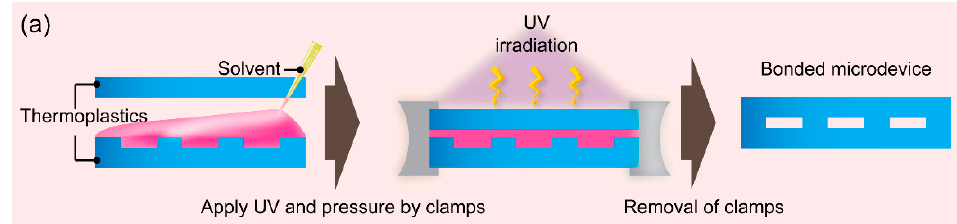
Figure 3. ( a ) Schematics showing the procedures for solvent bonding for fabricating thermoplastic devices. ( b ) The overall procedure for bonding two PMMA substrates via ethanol treatment fol ‐ lowed by UV irradiation, a chemical reaction is anticipated to take place on the surfaces of two PMMAs substrates after ethanol and UV treatment. Adapted with permission from Ref. [61]. Copyright 2013, Elsevier. ( c ) The overall procedure for bonding two PMMA substrates at room temperature by acetic acid under pressure. The photographs show bonded PMMA microdevice and cross ‐ section of the microchannels after the bonding, chemical bonds are anticipated to form between two PMMA substrates after acetic acid and pressure treatment. Adapted with permission from Ref. [33]. Copyright 2019, Elsevier. 3.3. Adhesive Bonding Adhesive bonding is a rapid and simple method for sealing thermoplastics where substrates are bonded at their interface by an adhesive (Figure 4c). Due to its simplicity, adhesive bonding is widely used for thermoplastics and for other materials. Liquid and dry adhesives can be used for specific requirements of thermoplastic bonding. A liquid adhesive usually requires a photo or thermal activation to form the bonded interface between two pieces of thermoplastic substrates. For example, microchannel and mi ‐ cropillar PMMA systems were bonded using a commercial UV adhesive (Slink 80801)